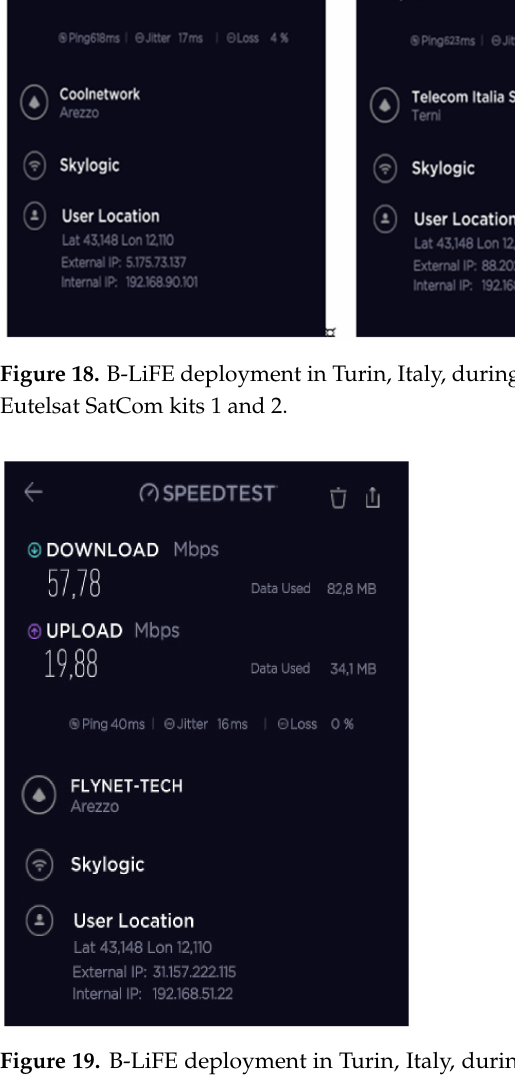
Figure 19. B-LiFE deployment in Turin, Italy, during the COVID-19 crisis: speed test results after combining the SES Scorpion MP80X terminal, 4G/LTE (Vodafone IT) modem, and Eutelsat SatCom (2 kits) using a load balance broadband